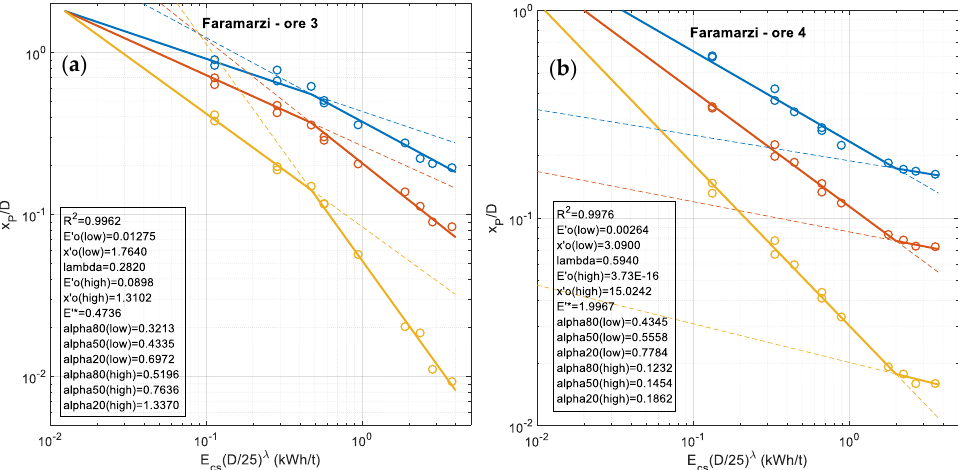
Figure A7. Double fans for Faramarzi’s [ 27] ore 3 ( a ) and ore 4 ( b ).